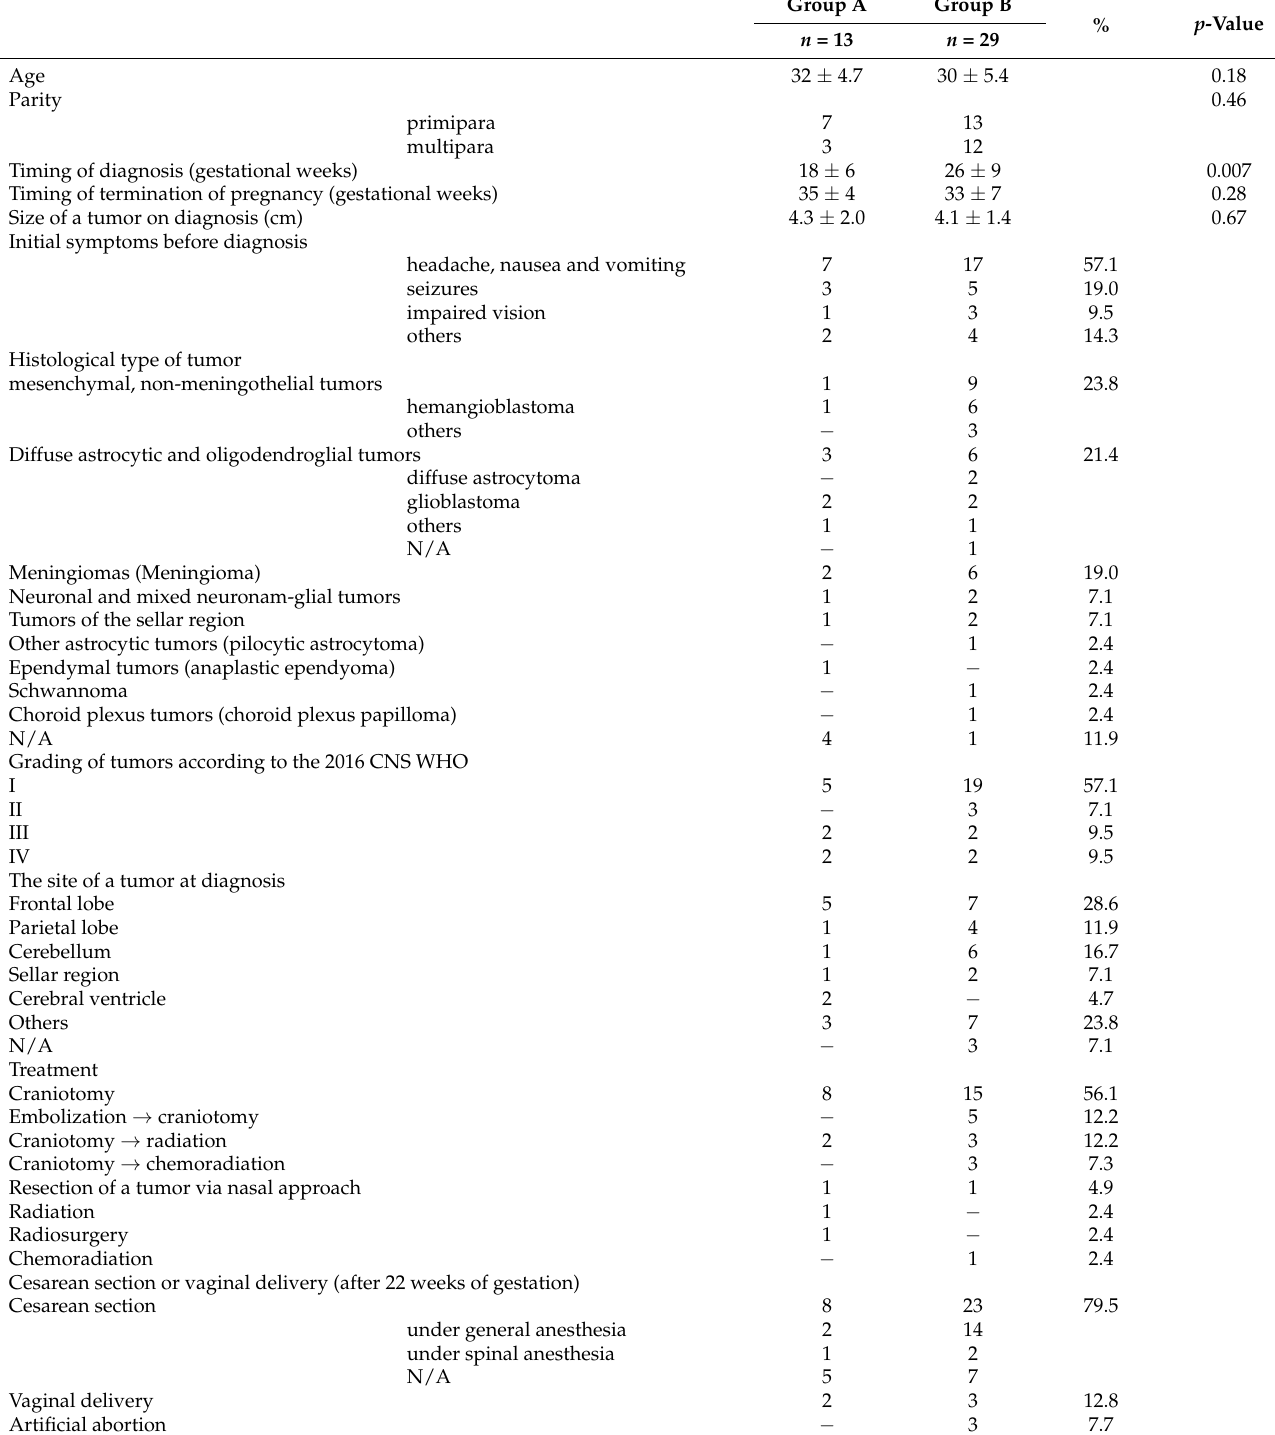
Table 1. The backgrounds and clinical findings of patients in the reviewed